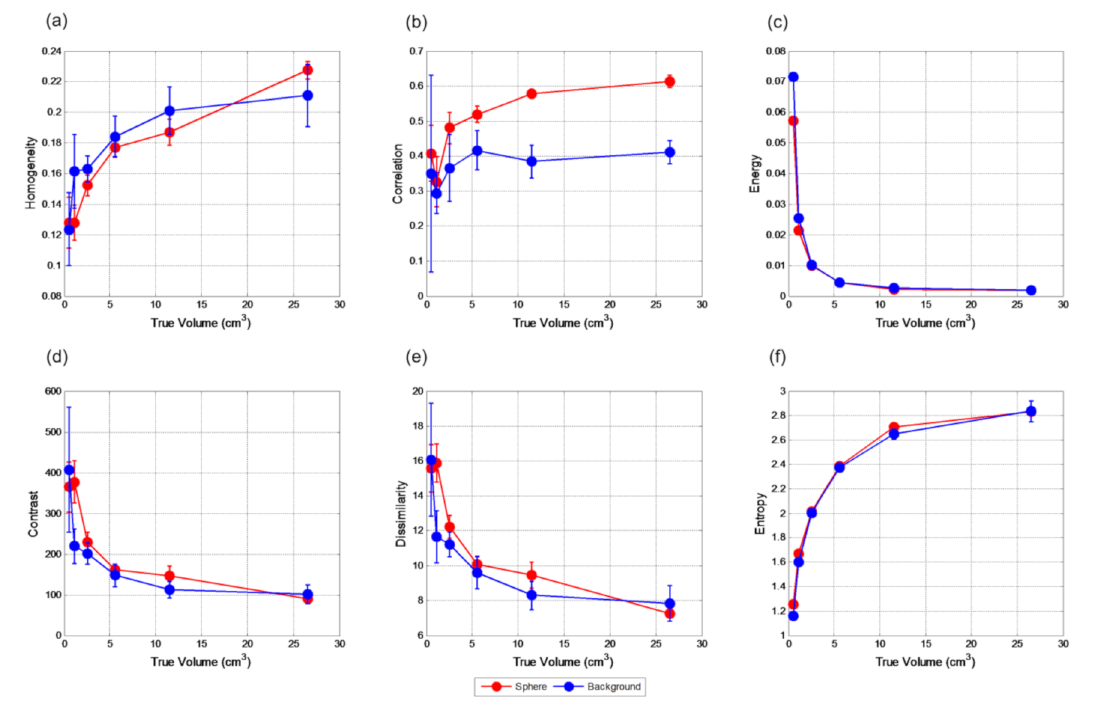
Figure 5. Six textural features vs. true volume (VOIt rue ) for contrast 4:1, 900 s acquisition, and quantization level 64 for both sphere and background. ( a ) Homogeneity, ( b ) contrast, ( c ) energy, ( d ) contrast, ( e ) dissimilarity and ( f ) entropy.